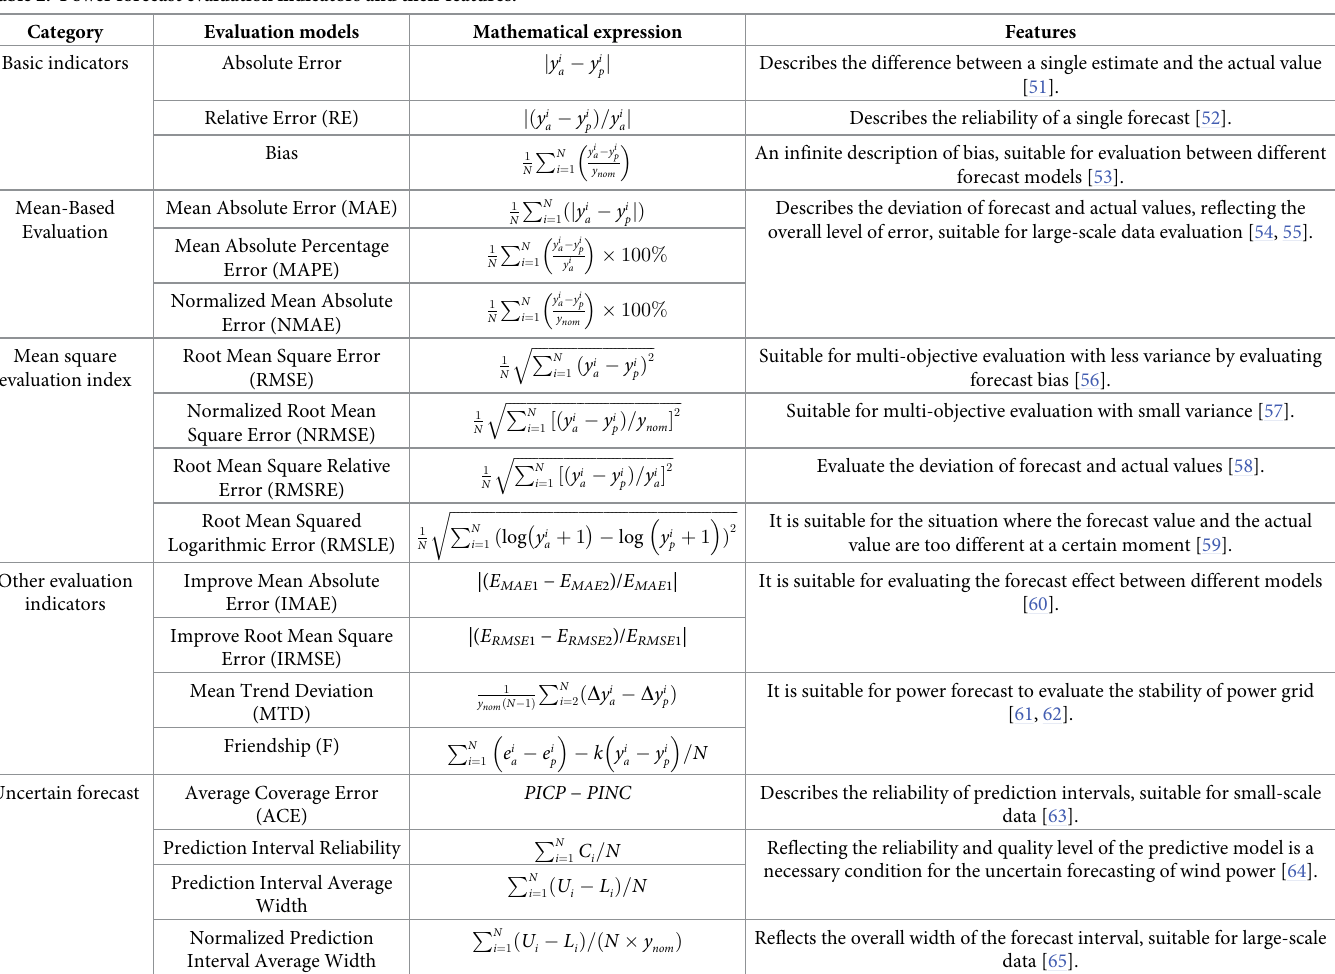
Table 2. Power forecast evaluation indicators and their